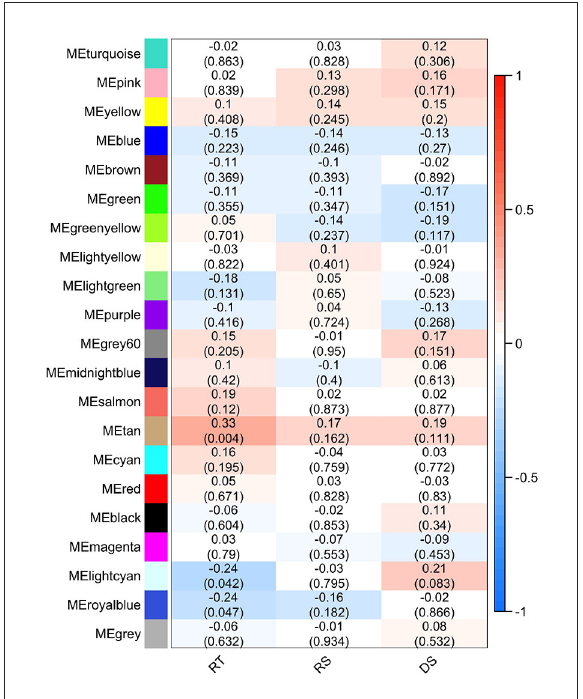
FIGURE6 Module-trait associations. Each row corresponds to a module eigengene, column to a trait-rectal temperature (RT), respiratory score (RS), and drooling score (DS). Each cell contains the corresponding Pearson’s correlation and P -value.